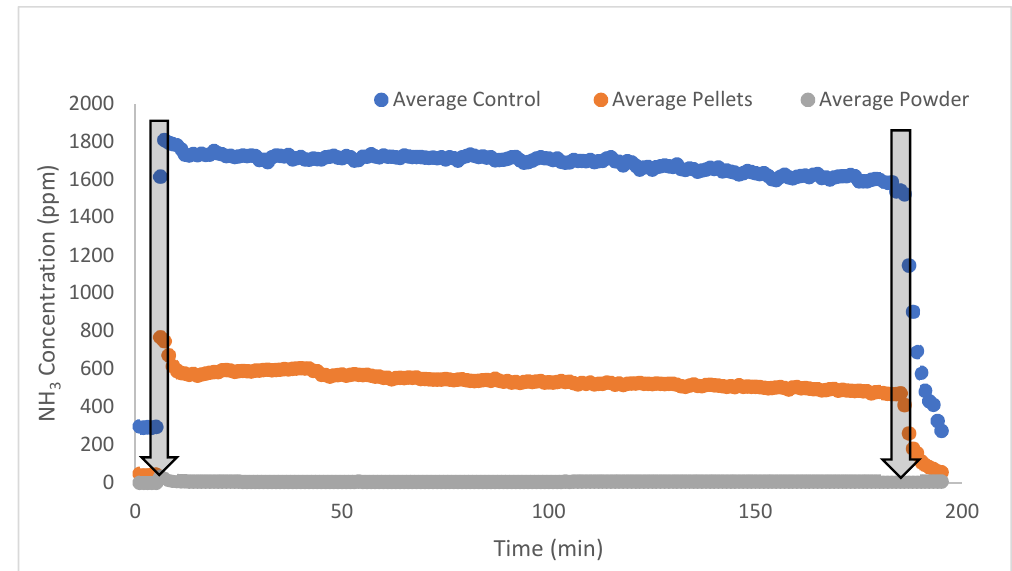
Figure 3. The average headspace concentrations of NH 3 during the 3 h agitation of swine manure treated with biochar pellets and powder. The vertical arrows indicate the start and end of manure agitation. The U.S. National Institute for Occupational Safety and Health (NIOSH) recommends the time-weighted average (TWA) 10-h concentration for NH 3 at 25 ppm and a short-term exposure limit (STL) of 15 min at 35 ppm (not shown to retain figure legibility).